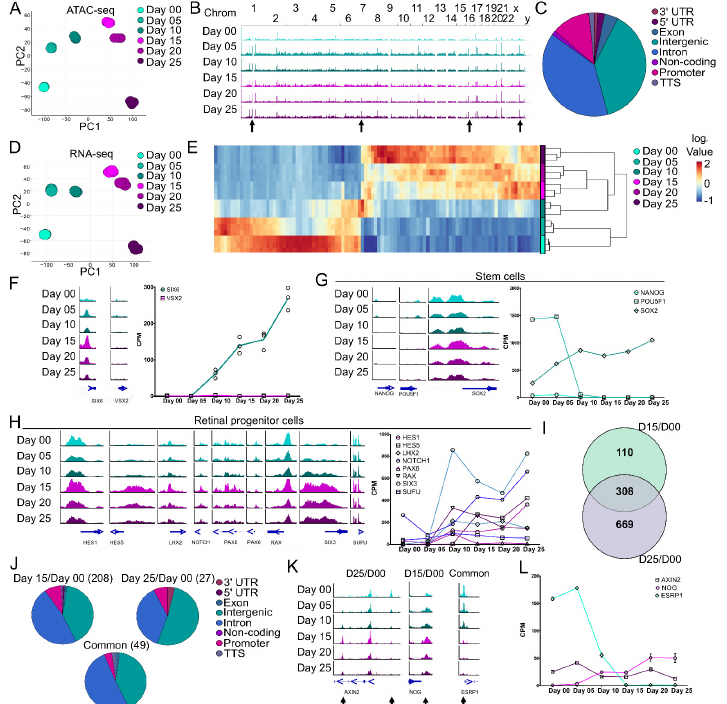
Figure 2. Chromatin accessibility and transcriptomic differences during retinal organoid formation from PSCs. IMR90.4- SIX6 -GFP/ VSX2 -tdTomato stem cells were differentiated into organoids up to day 25 and pooled (n = 3 replicates; 8–20 organoids/replicate) every 5 days for either ATAC- or RNA- seq analyses. ( A ) Principal component analysis (PCA) of ATAC-seq samples based on 62,201 peaks show a developmental progression over time with little variability between replicates. ( B ) Genomic ATAC peak tracks of the whole genome for days 00 through 25 indicate time-point specific changes (arrows) in chromatin accessibility. ( C ) A pie chart of global genomic annotations based on ATAC-seq analysis from days 00 through 25 identified a high proportion of intergenic, intronic, and promoter peaks. ( D ) PCA of RNA-seq samples from days 00 through 25 based on 12,512 expressed genes show a developmental progression over time with little variability between replicates. ( E ) A heatmap of the top 100 most significant differentially expressed genes between days 00 and 25 (Table S2). ( F ) Genomic tracks of SIX6 and VSX2 at the transcriptional start site (TSS) (left) and expression values from RNA-seq (right) show an increase in SIX6 TSS chromatin accessibility and gene expression but little/no changes in VSX2 . ( G ) Genomic tracks (left) and with mRNA expression line graphs (right) of characteristic stem cell markers. ( H ) Genomic tracks (left) and mRNA expression line graphs (right) of retinal progenitor cell markers. ( I ) A Venn diagram depicting DEG/DARs between different days 00, 15, and 25. Numbers indicate the number of differentially expressed/accessible DEG/DARs identified. ( J ) A pie chart of genomic annotations between the different time points from the comparison of ATAC- and RNA-seq. ( K ) Genomic tracks and ( L ) mRNA expression line graphs from DEGs identified ( I ) and their corresponding DARs (arrows). Scale for all genomic tracks =